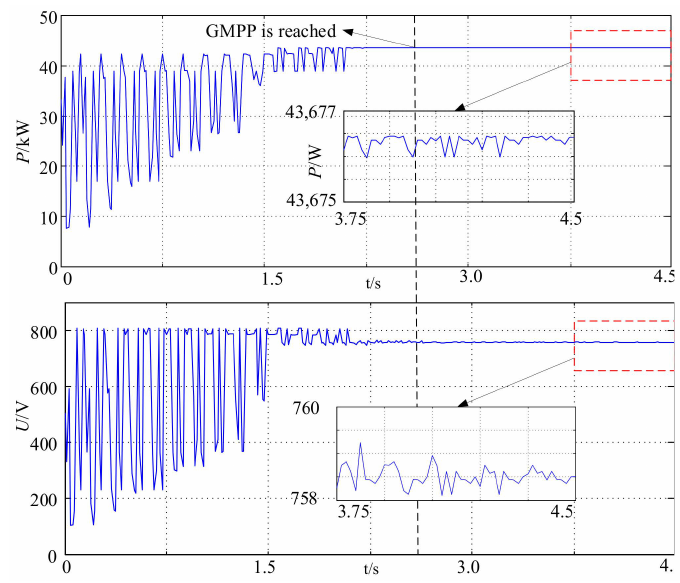
Figure 9. Voltage and power waveforms of FA for case 2 if GMPP occurs at right.